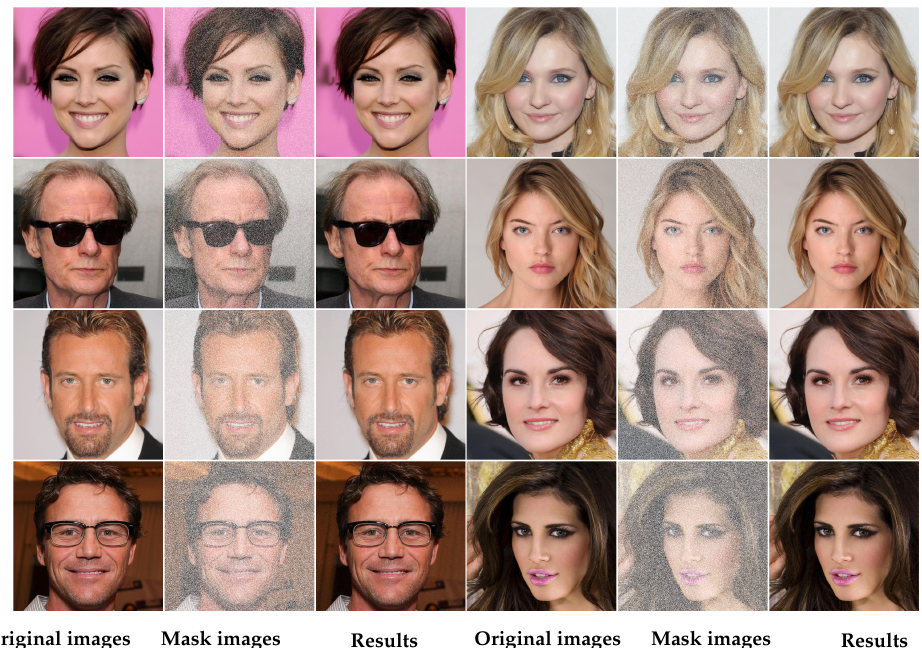
Figure 10. Inpainting results of masked images with different proportion noise. The first to fourth rows are 20%, 30%, 40% and 50% noise masks, respectively.